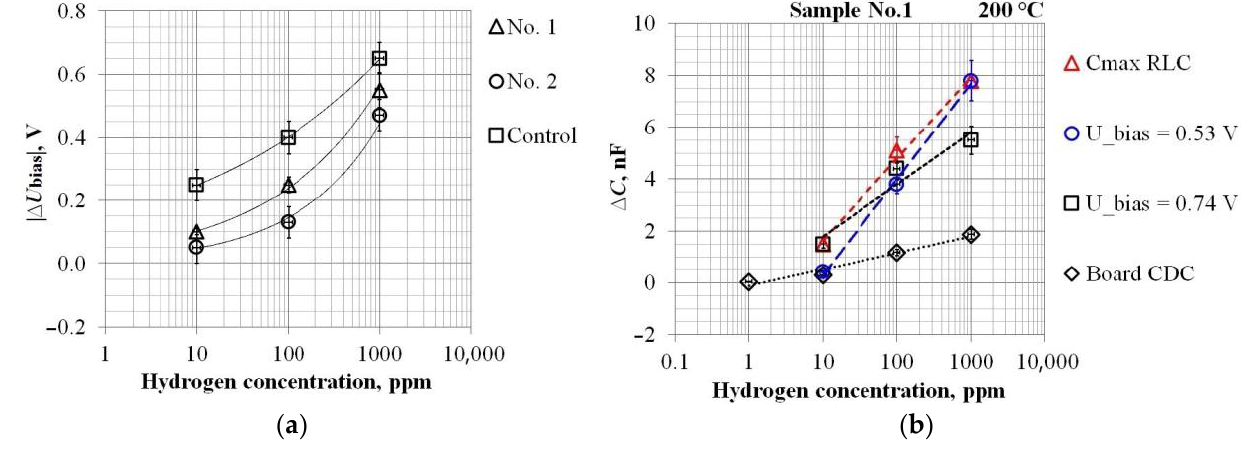
Figure 9. The sensors ’ calibration characteristics ΔU bias (C H2 ) ( a ). The calibration characteristics ΔC(C H2 ) of Sample No. 1 at the different measuring circuit operating settings and comparison with the experimental Board CDC data ( b ).